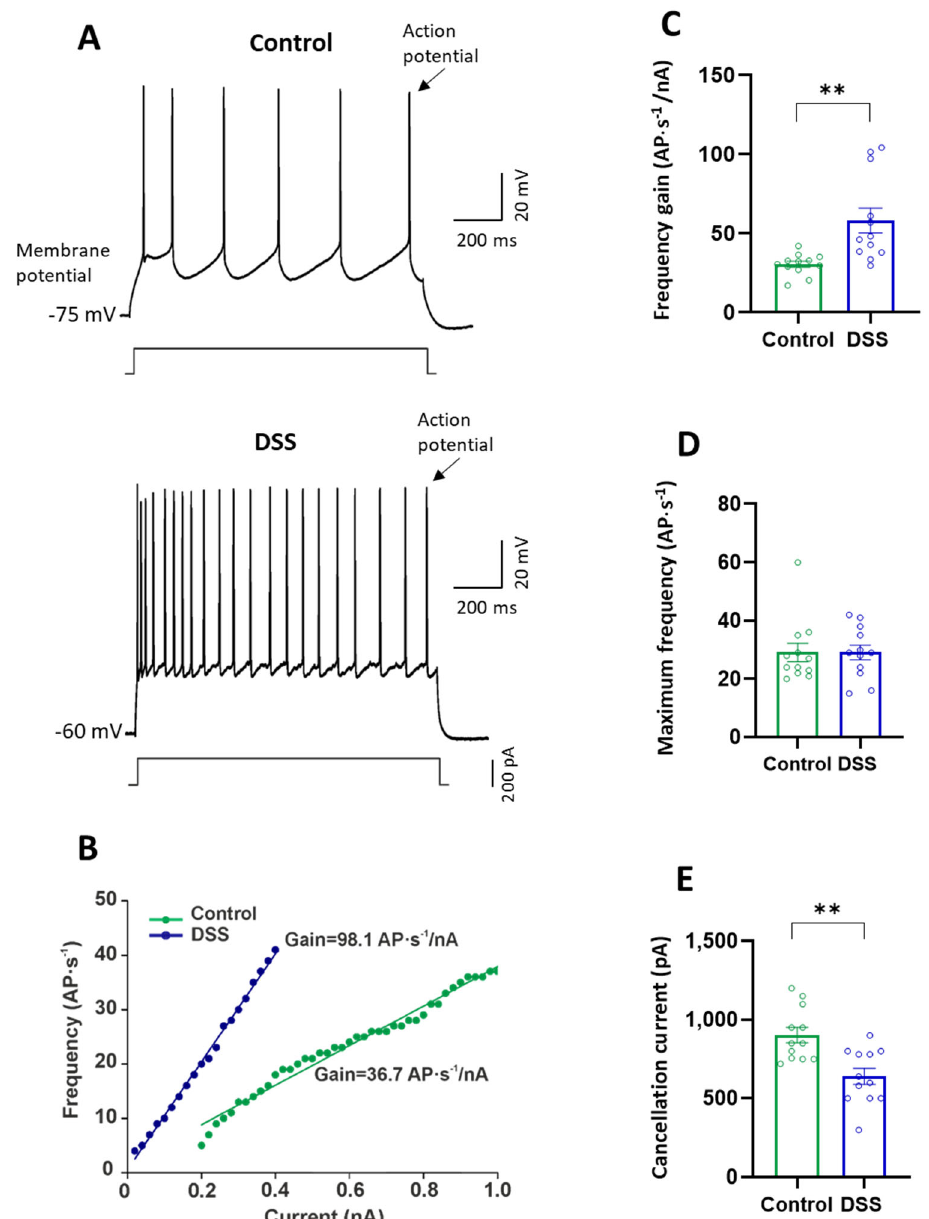
Figure 6. Firing properties of pyramidal neurons from the motor cortex of control and DSS ‐ treated rats. ( A ) Membrane potential responses to long ‐ lasting depolarizing current pulses (200 pA) in a representative neuron from control and DSS ‐ treated rats. ( B ) Relationship between current intensity and frequency of action potentials (AP) represented in (A). ( C ) Frequency gain (AP ∙ s ⁻ ¹/nA). ( D ) Maximum frequency (AP ∙ s ⁻ ¹). ( E ) Cancellation current (pA). Data are means ± SEM. The number of animals was 4 for each experimental condition and the number of neurons recorded from each animal was 2–4 ( n = 12 cells recorded in total for each group). Student’s t ‐ test: ** p <0.01, DSS ‐ treated rats vs . controls.